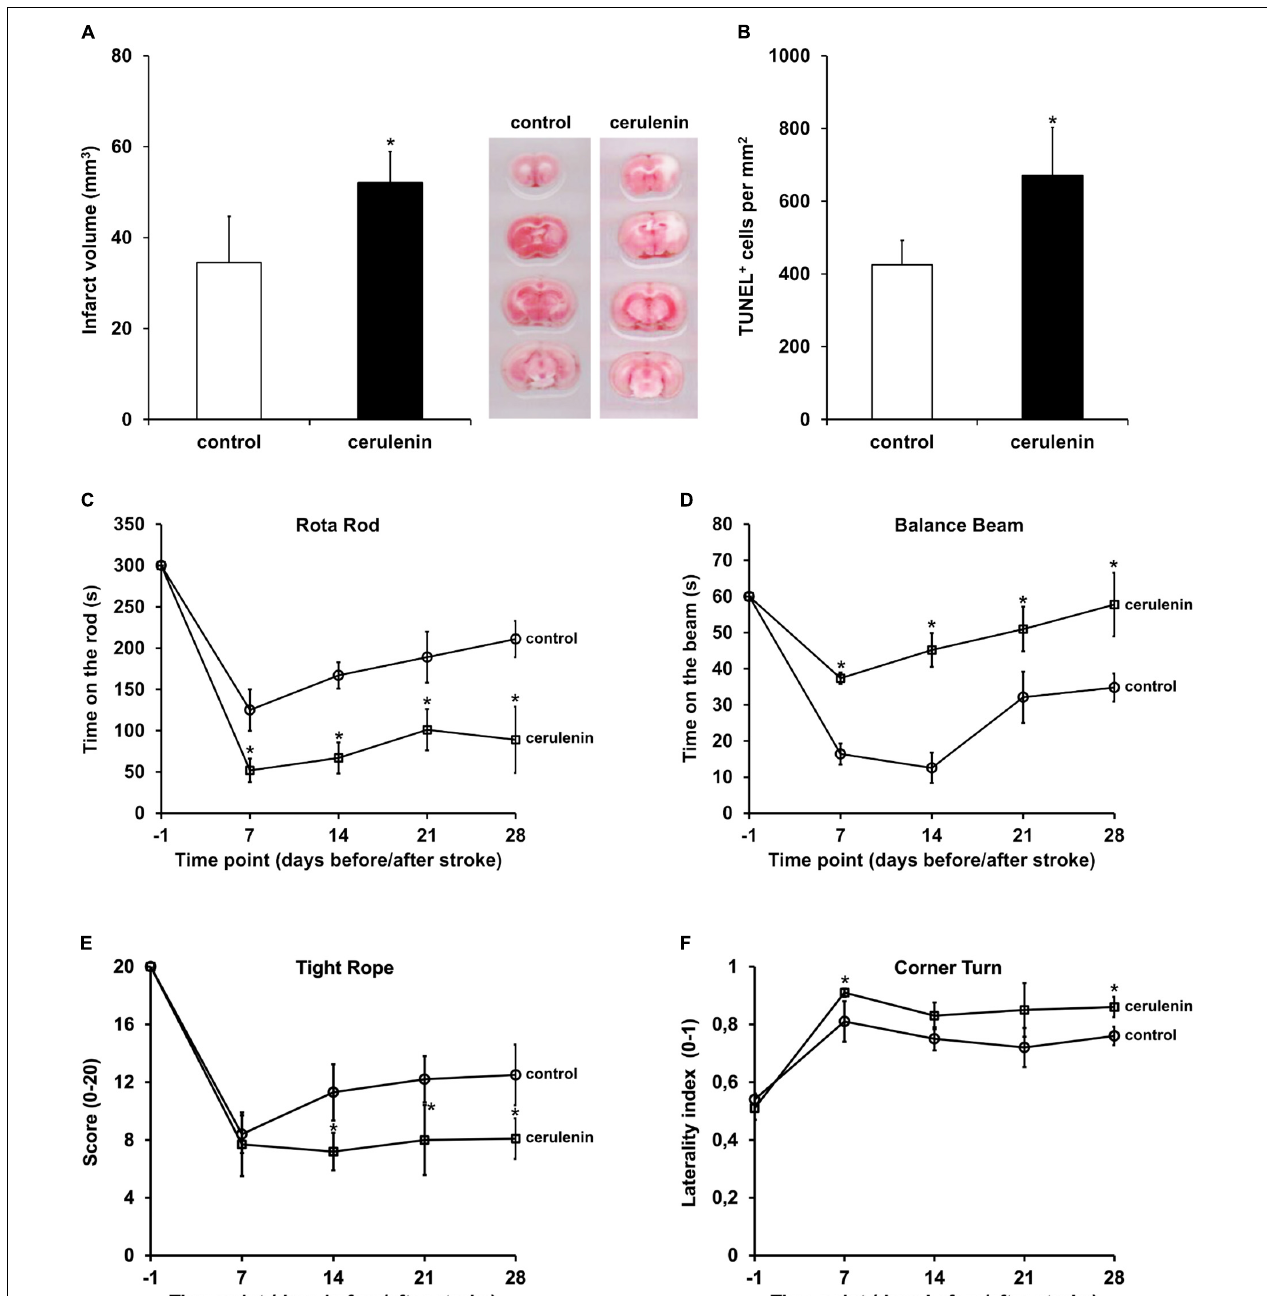
FIGURE 3 | Inhibition of FAS aggravates poststroke brain injury and motor coordination impairment. Mice were either treated with DMSO (control) or with cerulenin (50 mg/kg body weight). Brain injury was assessed using TTC staining ( n = 6 per condition) on day 4 (A) or TUNEL staining ( n = 8 per condition) on day 7 (B) . Behavioral tests ( n = 21 per condition) were performed during an observation period of 4 weeks at the time points given (circles: controls, squares: cerulenin). The tests included the rota rod (C) , balance beam (D) , tight rope (E) , and corner turn test (F) . All animals were trained before induction of stroke in order to ensure proper test performance. *Significantly different from controls, p <